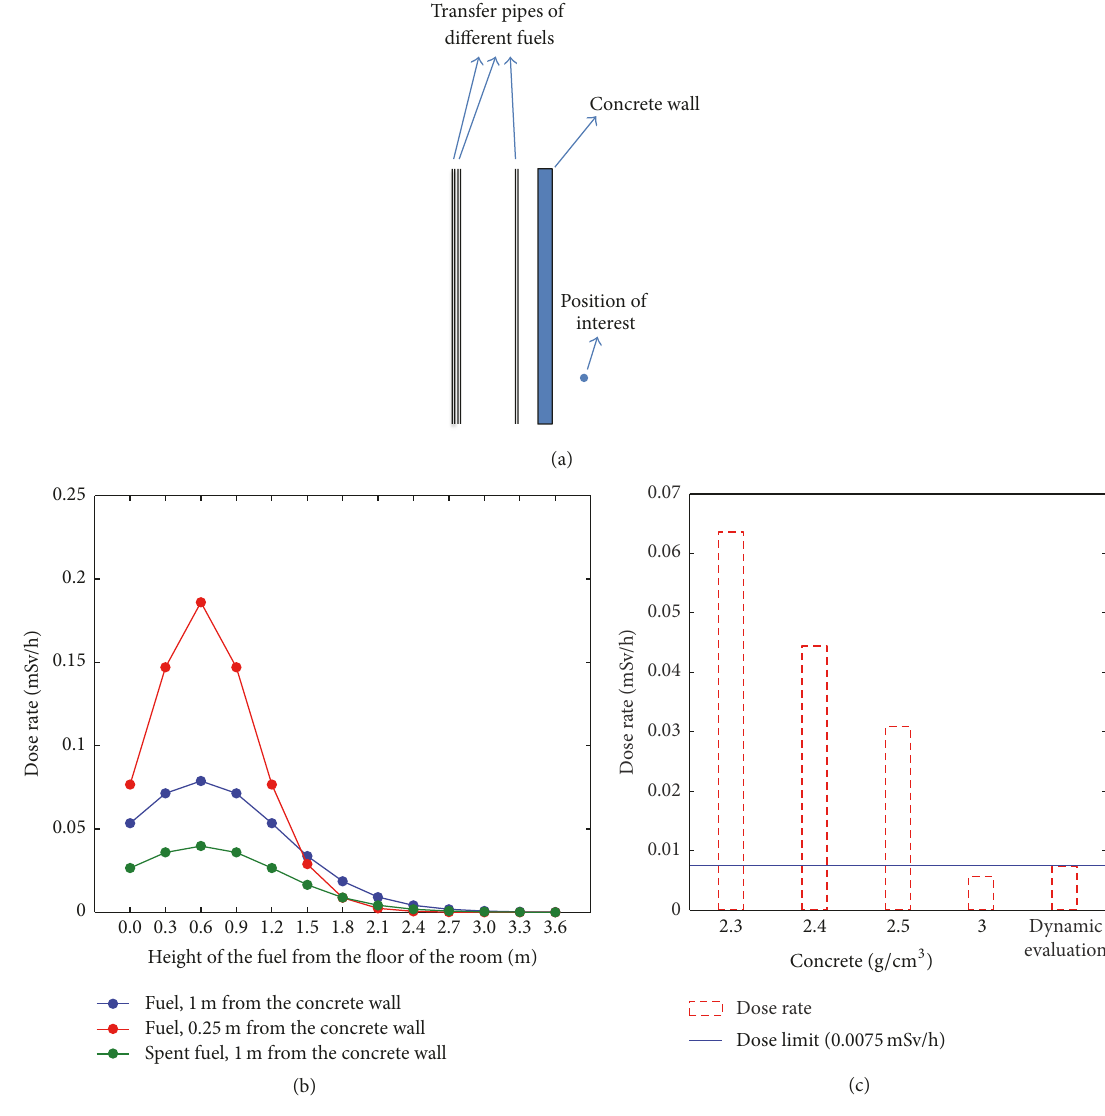
Figure 5: (a) An example of fuels moving and irradiating a position of interest; (b) the dynamic evaluation of dose rates; (c) dose rates with different densities of the concrete and dynamic